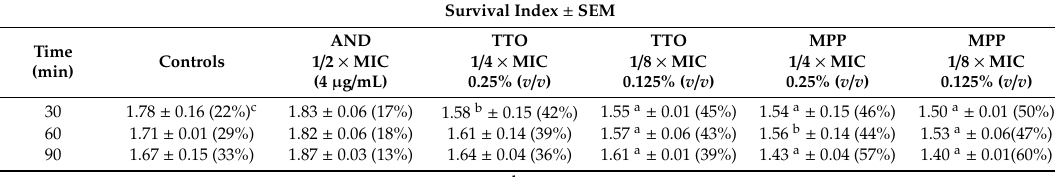
Figure 1. PMN percent survival: effect of sub-inhibitory concentrations of Melaleuca alternifolia (TTO) and “Mentha of Pancalieri” (MPP) essential oils on PMN viability at 30, 60, and 90 min. Data presented as the average ± SEM. TTO = Tea Tree Oil; MPP = “Mentha of Pancalieri” essential oil. To investigate the direct effect of EOs and the drug on the intra-phagocyte killing, yeast cells and PMNs were pre-incubated for 60 min with sub-inhibiting concentrations of TTO, MPP, or AND. After withdrawal of the antimicrobial agents, the fungicidal activity was determined. Table 3. Effect of 1 h of pre-exposure of Candida krusei to anidulafungin (1/2 × MIC), TTO or “Mentha of Pancalieri” essential oil (1/4 × MIC; 1/8 × MIC) on PMNs intracellular killing. The PMN killing values were expressed as a Survival Index ± SEM (standard errors of the means), calculated as the number of surviving microorganisms at 30 min (T o ) plus the number of surviving microorganisms at T x divided by the number of surviving microorganisms at T o .